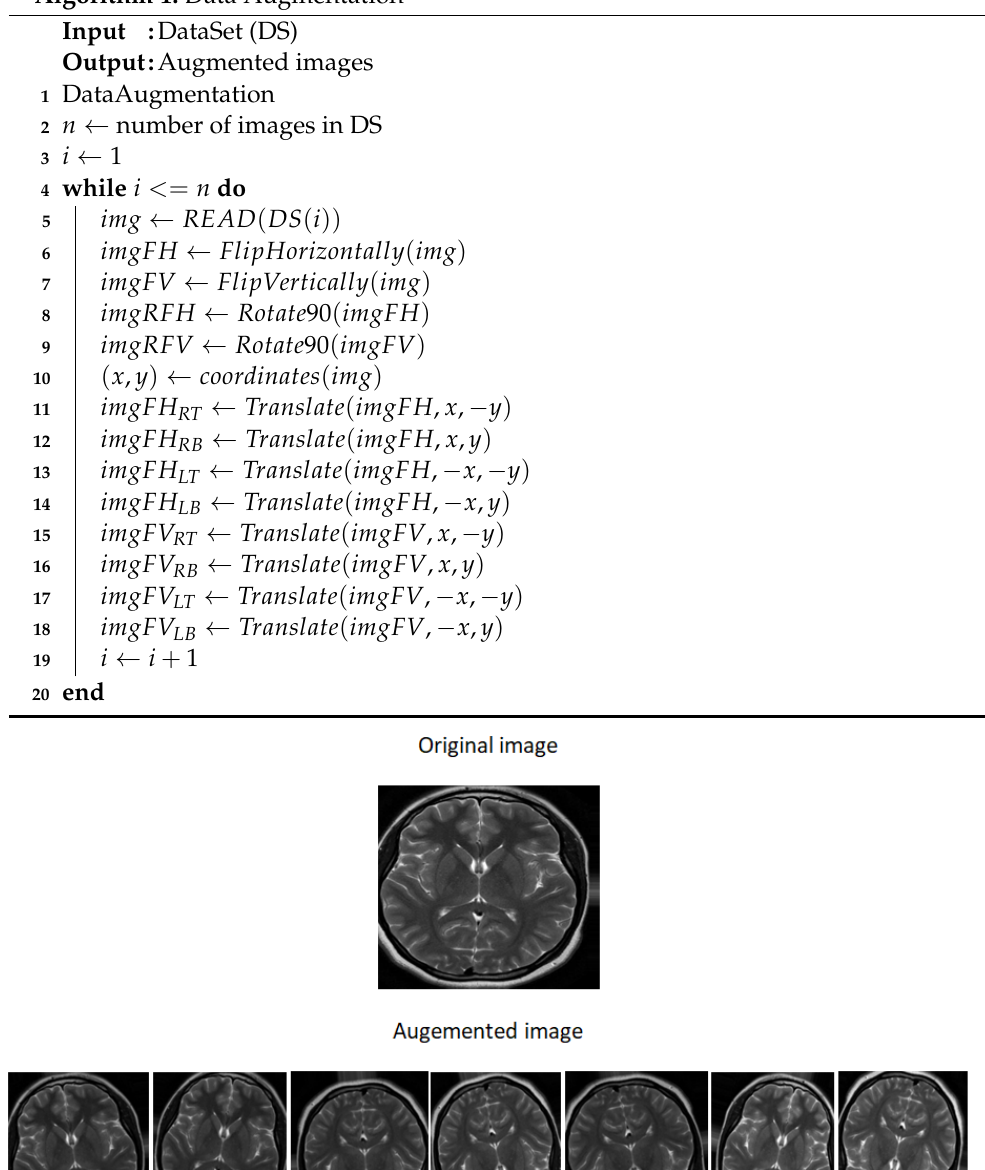
Algorithm 1: Data Augmentation